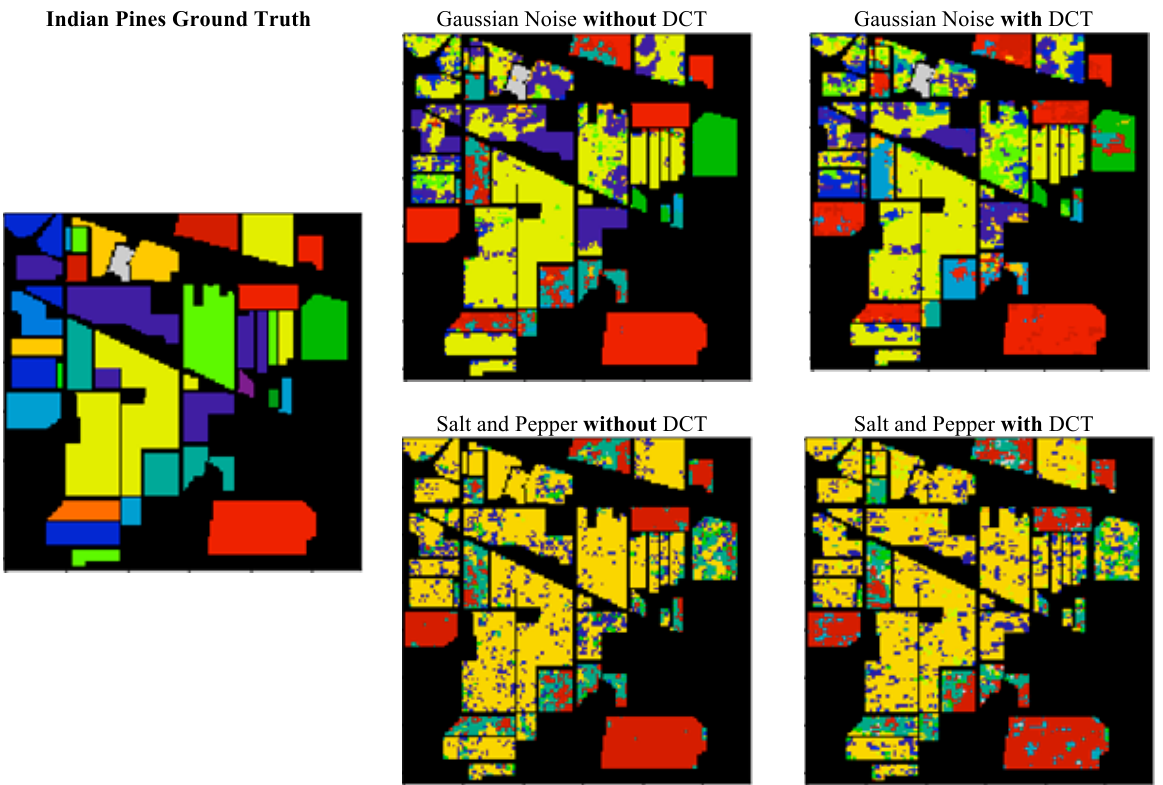
Figure 3: Indian Pines Dataset: Classification maps for indicative CNN-based